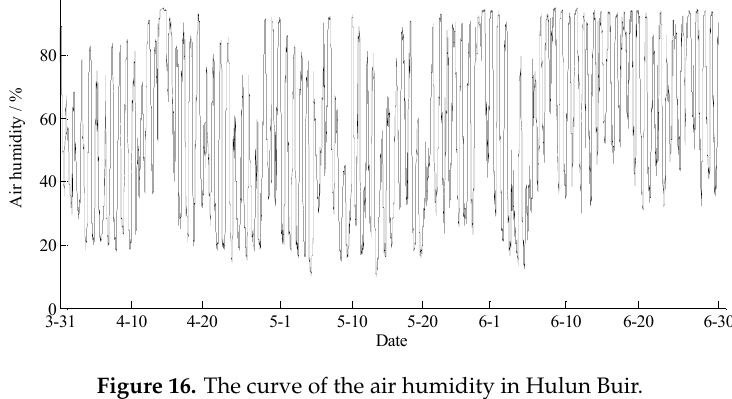
Figure 15. The curve of the wind speed in Hulun Buir.